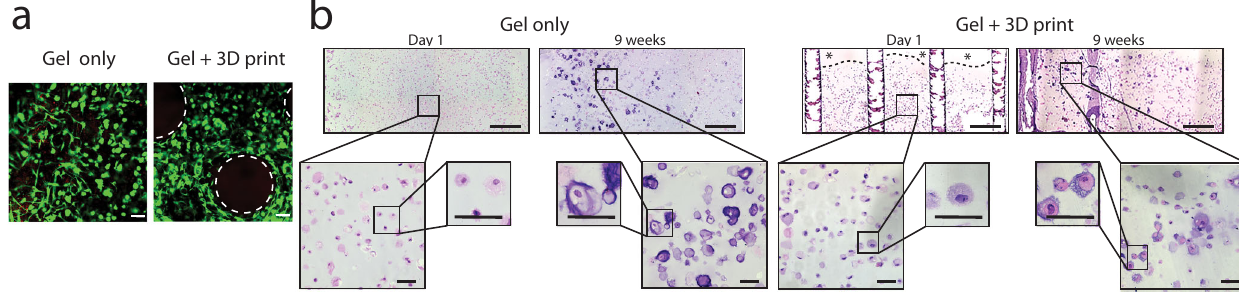
Fig. 4 The 3D printed structure supports rabbit MSC viability and morphology in the cartilage-mimetic hydrogel. a Representative live/ dead staining of samples at 9 weeks (scale bar = 50 µm). Scaffold pillars in the Gel + 3D print condition are outlined in dashed white line. b Representative H&E images of the plastic embedded Gel only and Gel + 3D print conditions at day 1 and at 9 weeks. 10x images (scale bar = 500 µm) highlight the distribution of cells in each condition. * denotes small areas where lack of observable cells is a result of sectioning artifacts, dashed line shows where section was torn. 40x insets (scale bar = 50 µm) highlight round cell morphology and deposition of pericellular matrix in both conditions after 9 weeks of